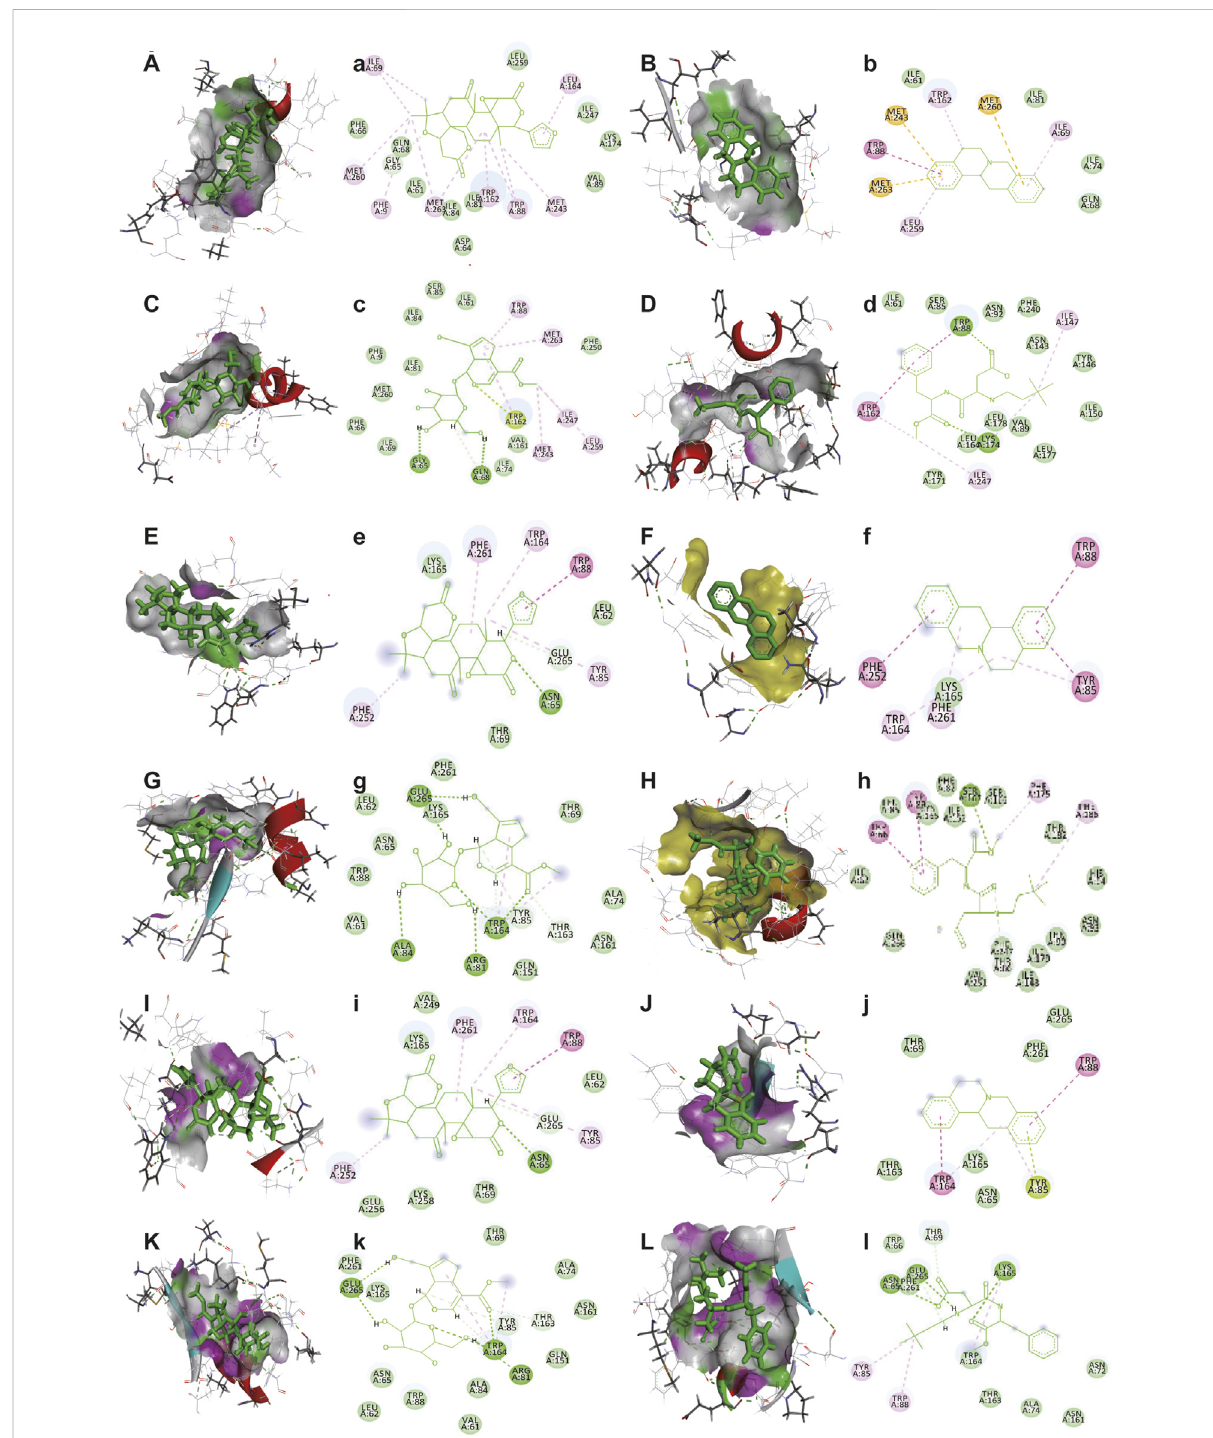
FIGURE 6 Interaction diagrams of bitter receptors with limonin, epiberberine, geniposide, and neotame. (A – L) Active pockets of limonin, epiberberine, geniposide, and neotame in Tas2r10, Tas2r14, and Tas2r46, respectively. (a – l) 2D diagram of receptor (Tas2r10, Tas2r14, and Tas2r46)-ligand (limonin, epiberberine, geniposide, and neotame), respectively. (A,a) Tas2r10 with limonin, (B,b) Tas2r10 with epiberberine, (C,c) Tas2r10 with geniposide, (D,d) Tas2r10 with neotame, (E,e) Tas2r14 with limonin, (F,f) Tas2r14 with epiberberine, (G,g) Tas2r14 with geniposide, (H,h) Tas2r14withneotame, (I,i) Tas2r46withlimonin, (J,j) Tas2r46withepiberberine, (K,k) Tas2r46withgeniposide,and (L,l) Tas2r46withneotame.Light green indicates van der Waals interaction. Green indicates hydrogen bond interaction. Rose-red indicates pi – pi interaction. Sulfur yellow indicates pi – sulfur